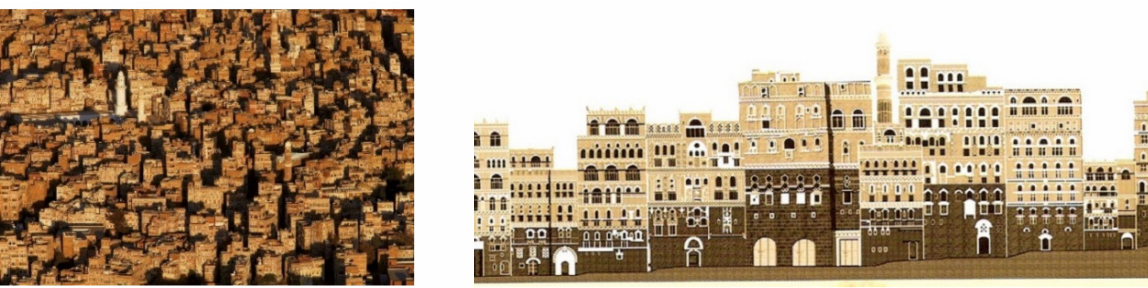
Figure 5. Sky view of the urban fabric and urban facades in the city of old Sana’a